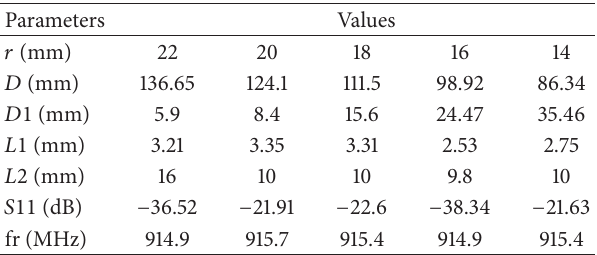
Table 6: Dimensions of each antenna (Figure 14) with the results of the simulation.